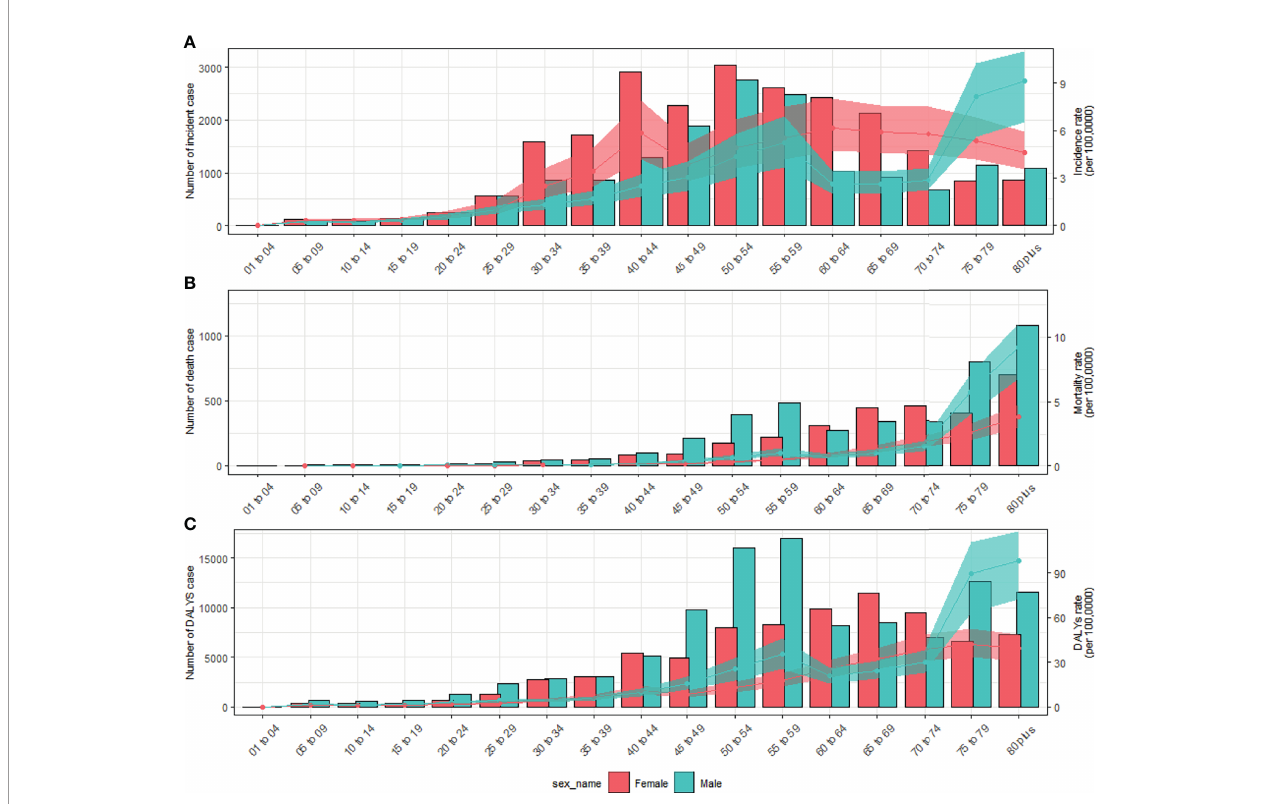
FIGURE 2 | Numbers and rates of incidence (A) , death (B) , and DALYs (C) of thyroid cancer by age and sex in 2019 in China. Shading represents the upper and lower limits of the 95% uncertainty intervals (95% UIs). DALYs, disability-adjusted